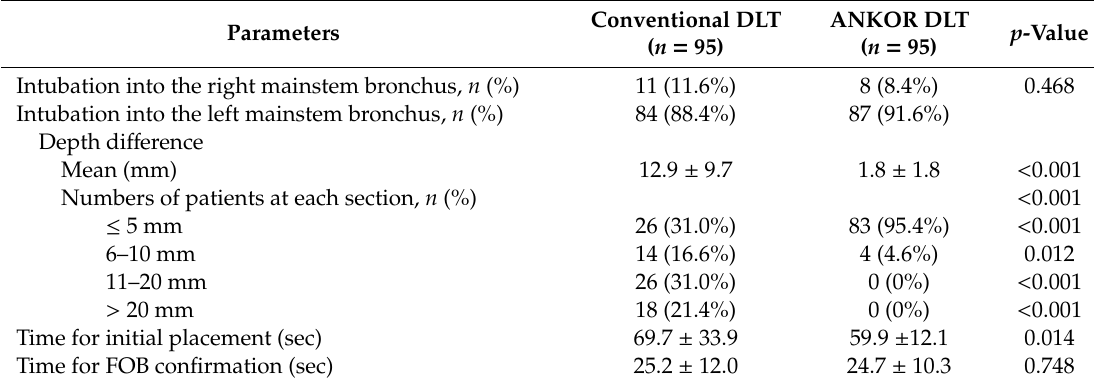
Table 2. Direction of left-sided DLT endobronchial intubation, depth di ff erence between initial DLT positioning and target depth confirmed by FOB, and time for DLT positioning and FOB confirmation.